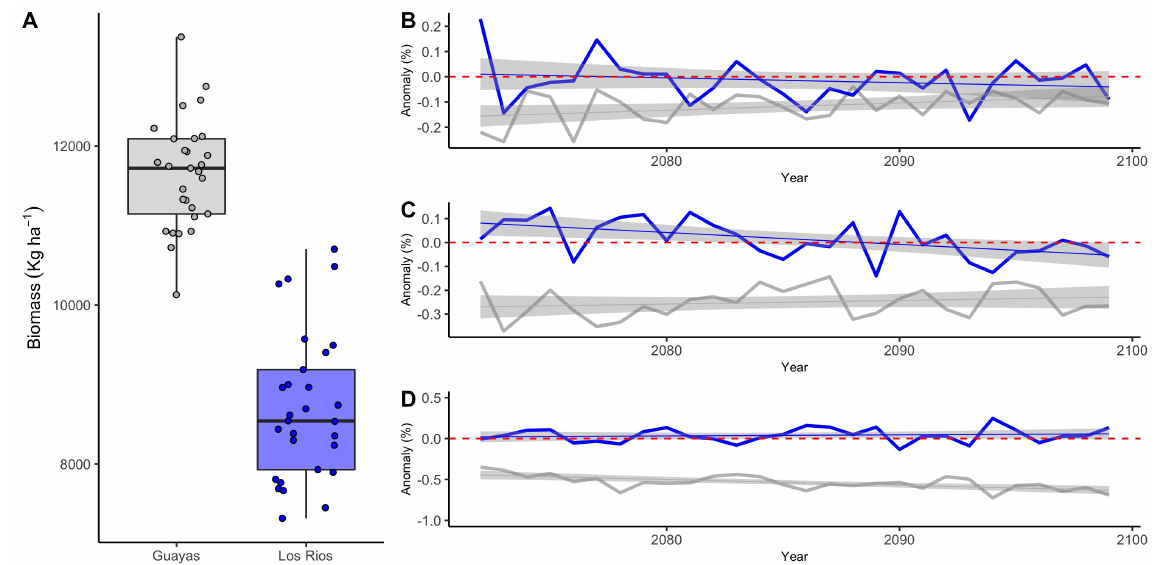
Figure 6. Percent change anomalies in rice total biomass projected from the RegCM4 RP VSM production ( A ) for the provinces of Guayas (gray) and Los Ríos (blue), with corresponding changes over the time period under RCP 2.6 ( B ), RCP 4.5 ( C ), and RCP 8.5 ( D ). The lines represent the annual changes in yield. Grey-shaded areas in ( B – D ) represent 95% prediction confidence.